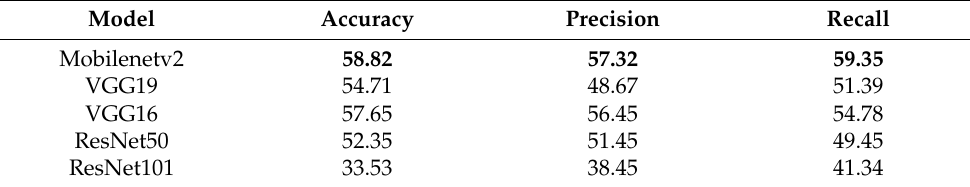
Table 3. CNN models classification accuracy, precision, and recall (%) prior to enhancement.